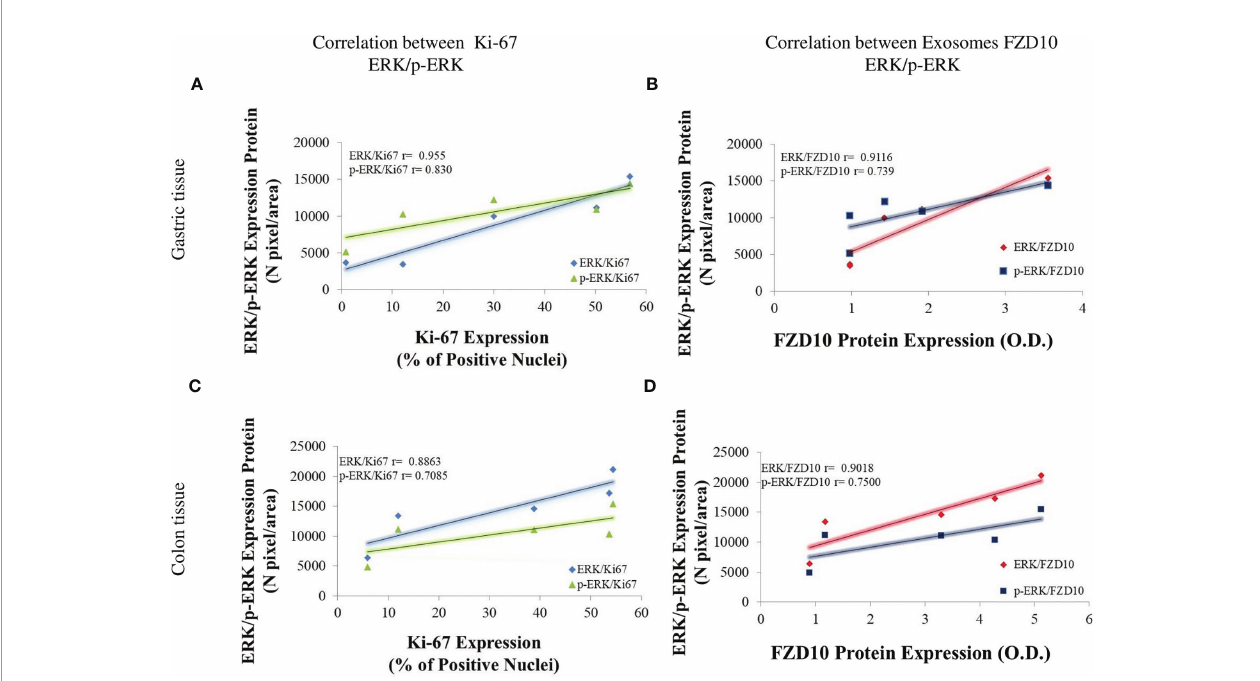
FIGURE 7 | Pearson ’ s correlation of all evaluated markers. Pearson ’ s correlations between expression levels of Ki-67 vs . extracellular signal-regulated protein kinase ( ERK)1/2 (blue line) and Ki-67 vs . p-ERK (green line) by immuno fl uorescence analysis in gastric cancer (GC) (A) or colorectal cancer (CRC) (C) tissues at different TNM stages (A, C) . Pearson ’ s correlations between expression levels of ERK1/2 vs . Frizzled (FZD)10 (red line) and p-ERK vs . FZD10 (dark blue line). Expression levels of FZD10 were evaluated in exosomes by Western blotting analysis, while expression levels of ERK and p-ERK were evaluated in tissues by immuno fl uorescence analysis of GC (B) or CRC (D) patients at different TNM stages (B, D) . In all the plots, each point was obtained as average value of all enrolled CRC or GC patients enrolled at the same TNM stage (from T1 to T4). p <